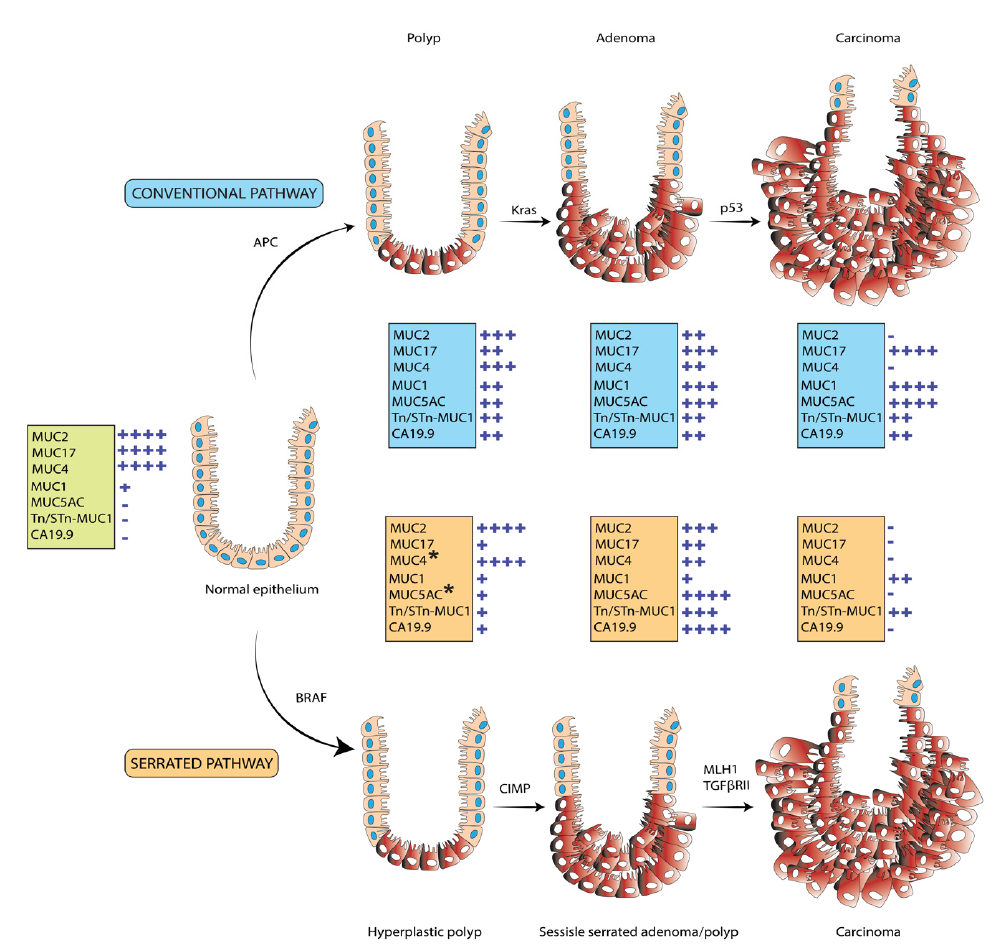
Figure 1. Mucin expression in precursor lesions leading to development of colon cancer. Traditional or conventional development of colon cancer is accompanied by frequent mutations in Adenomatous polyposis coli (APC), Kras and p53 mutations with pathological formation of polyps-adenoma-carcinoma. In contrast, serrated pathway is accompanied by preponderance of BRAF-mutation, high in CpG island methylator phenotype (CIMP) and have MSI-H or microsatellite stability (MSS) along with TGF β RII mutations. Differential expression of mucins and associated O-glycans in polyp-adenoma-carcinoma sequence of both pathways. * Differential localization of mucins (MUC4 and MUC5AC) is observed in the hyperplastic and sessile serrated adenomas/polyps’ subtypes of serrated pathway.